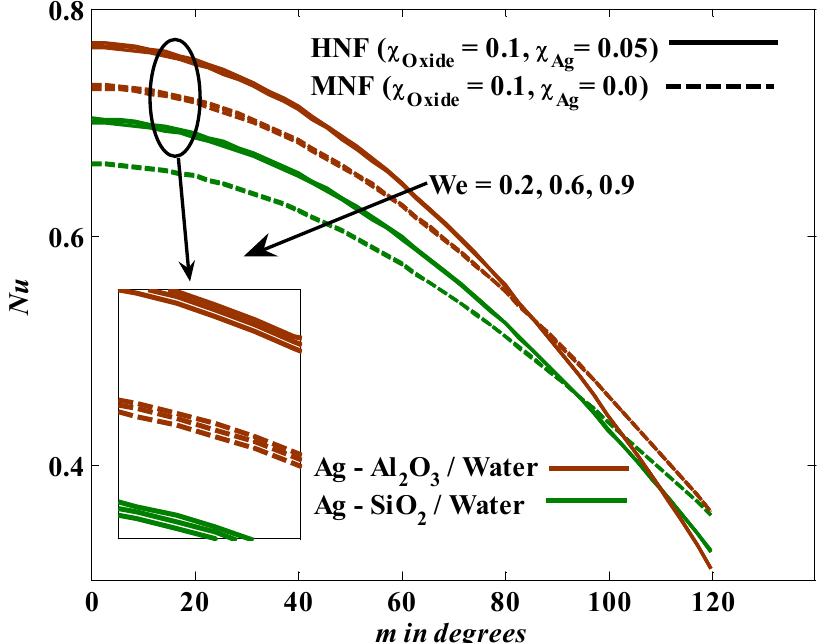
Figure 2. Illustration of We versus Nusselt number at fixed values of R = 0.2, λ = 0.1, & M =